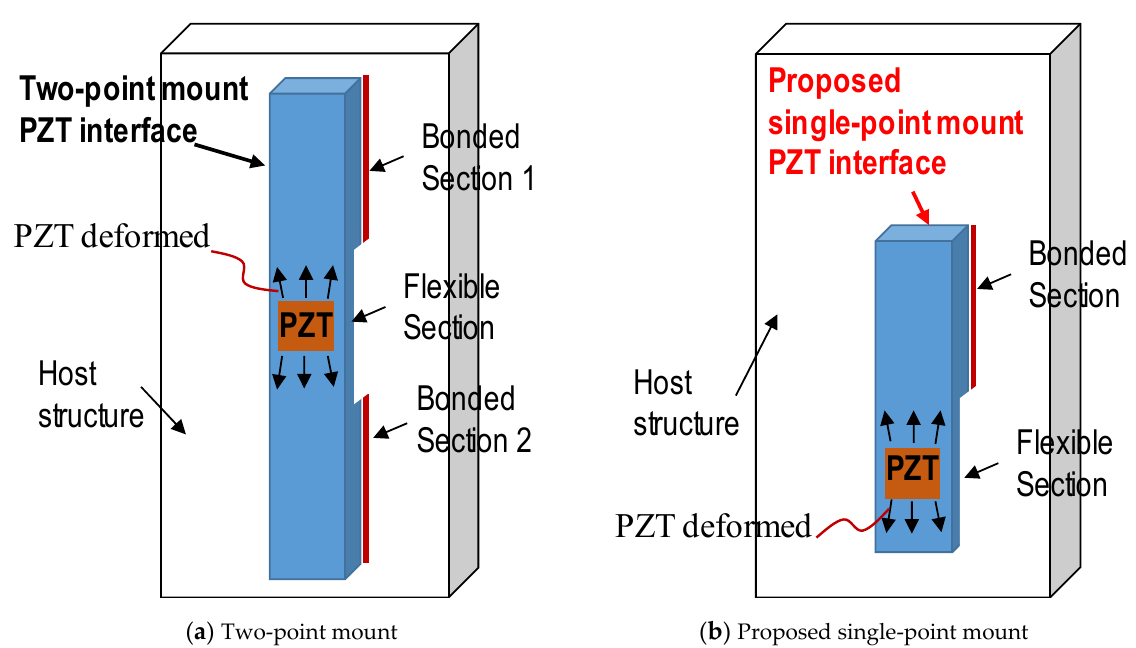
Figure 2. Conceptual design of the mountable PZT interface: two-point mount vs. single-point mount.